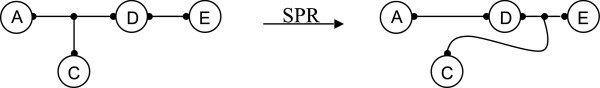
Species tree extension. From left to right, input mul-tree , the species tree , and the mul-tree S*. S* is the extension of  relative to .